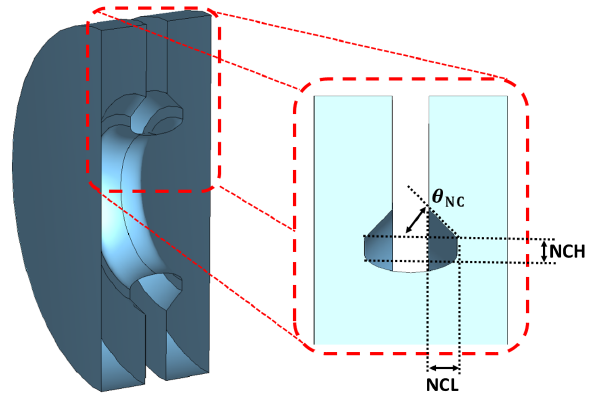
FIG. 10. Geometric parameters of the nose cone for a reentrant cell